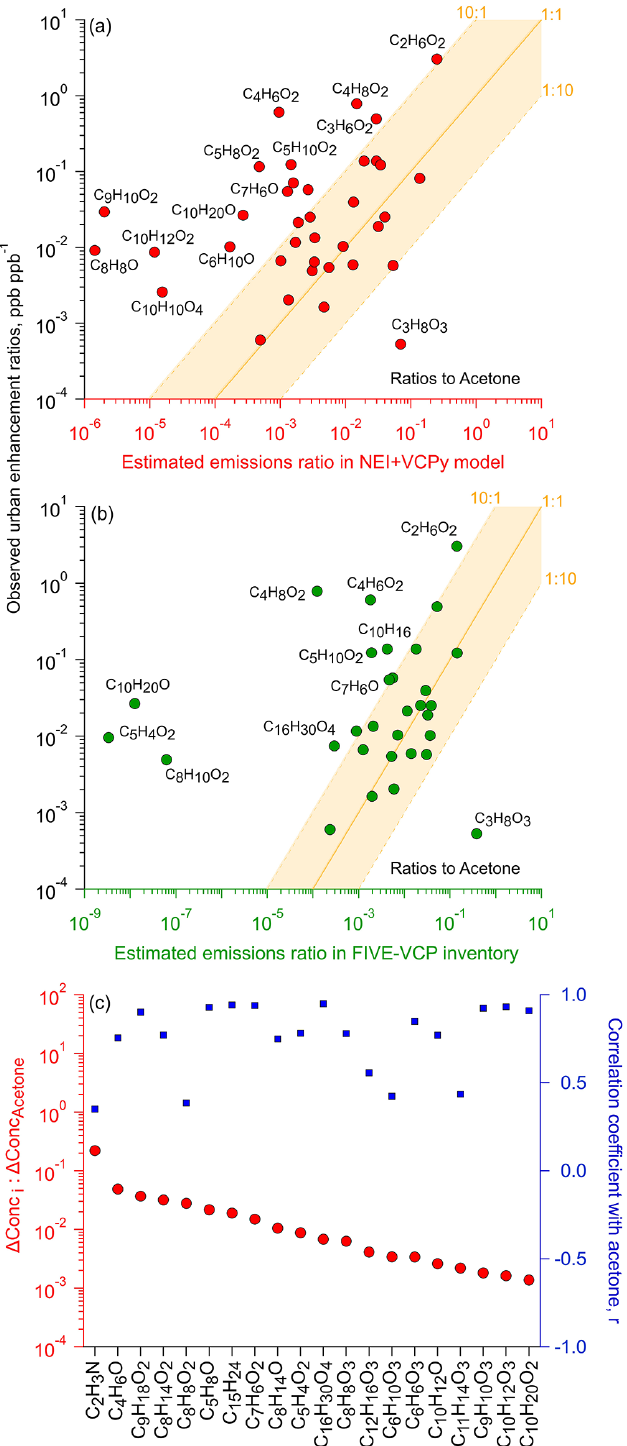
Figure 7. Comparison of ambient observations to emission inventories (including all inventoried anthropogenic sources). Urban concen- tration enhancement ratios against acetone (calculated via background-subtracted geometric means) compared to estimated emission ratios using the (a) VCPy model (plus other anthropogenic sources in NEI) and (b) FIVE-VCP inventory (shown for compounds with explicit estimates in each inventory – see Table 1). (c) Concentration enhancement ratios against acetone (and correlation coefficients) for calibrated ions where emissions data were not available in VCPy (a) . Note: examples of isomers contributing to ions in (a) and (b) are listed in Tables 1 and